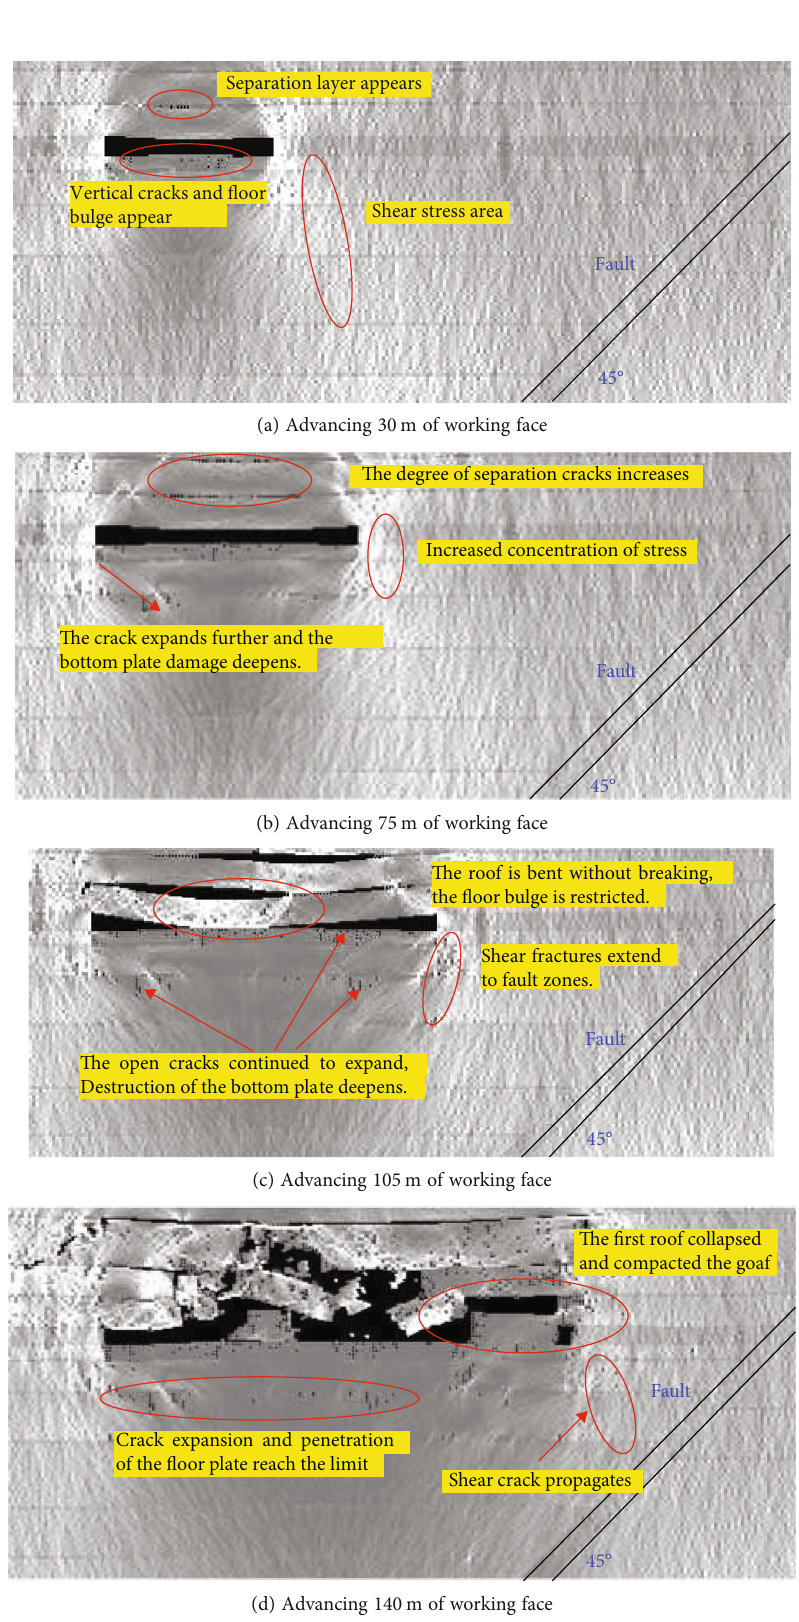
Figure 10: Mining crack evolution process (30 m, project